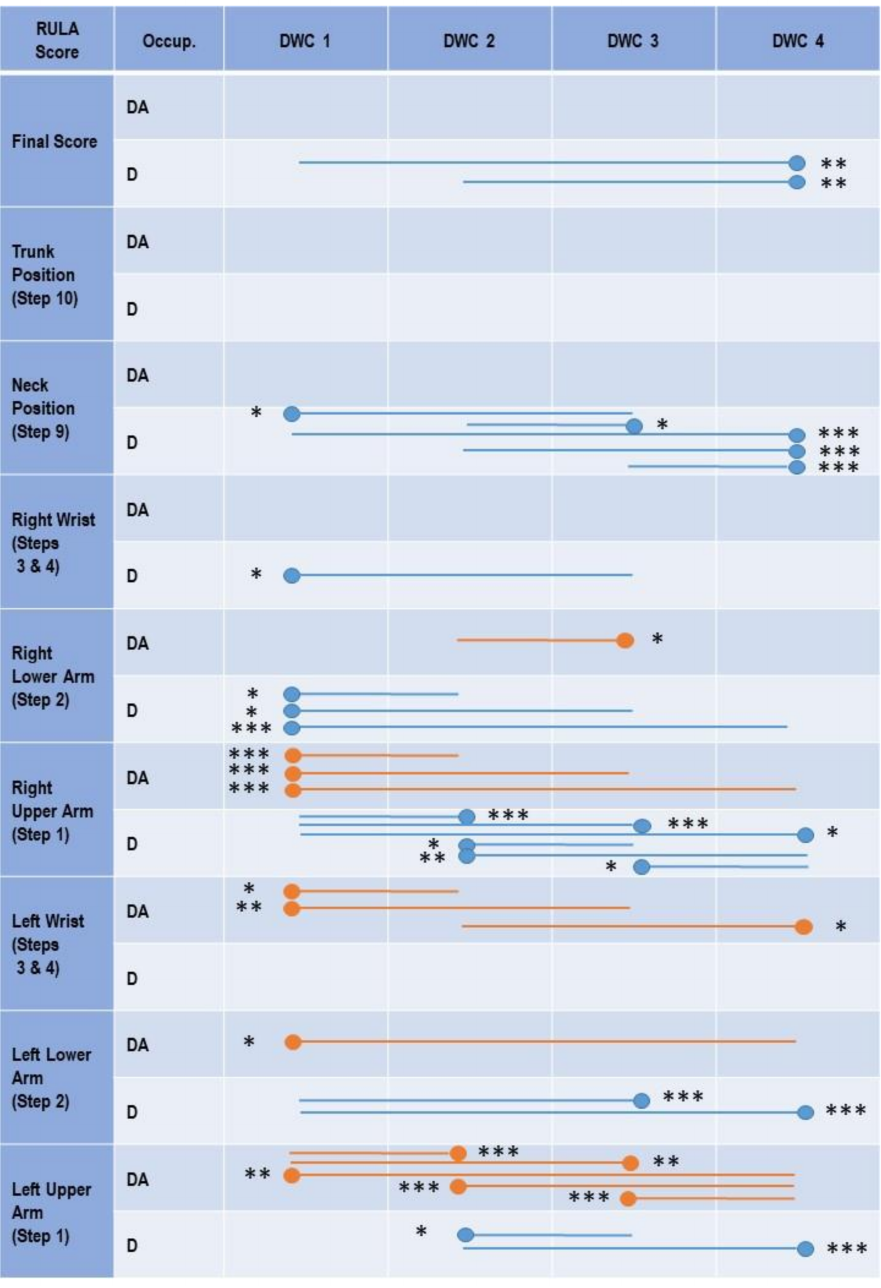
Figure 3. Significant differences of the relative average risk score over the time between the four DWCs for DAs (orange lines) and Ds (blue lines) in the outcomes: final overall, trunk score, neck score, wrist score left and right, lower arm score left and right, and upper arm score left and right. Significant differences are marked with lines indicating the relevant DWCs. Significance level: * ≤ 0.05, ** ≤ 0.01, *** ≤ 0.001. The circle marks the DWC with the significantly lower ergonomic risk score. Occup.— occupation; DWC—dental workplace concept; D—dentist; DA— dental